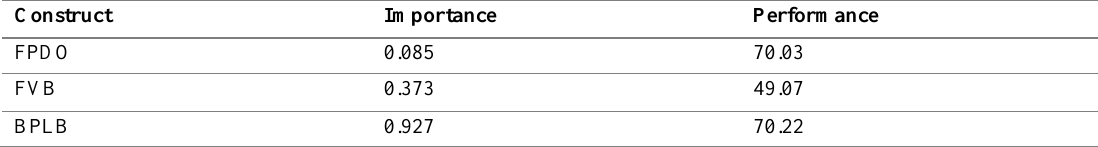
Table 6: Importance -Performance Analysis for Followers Radical